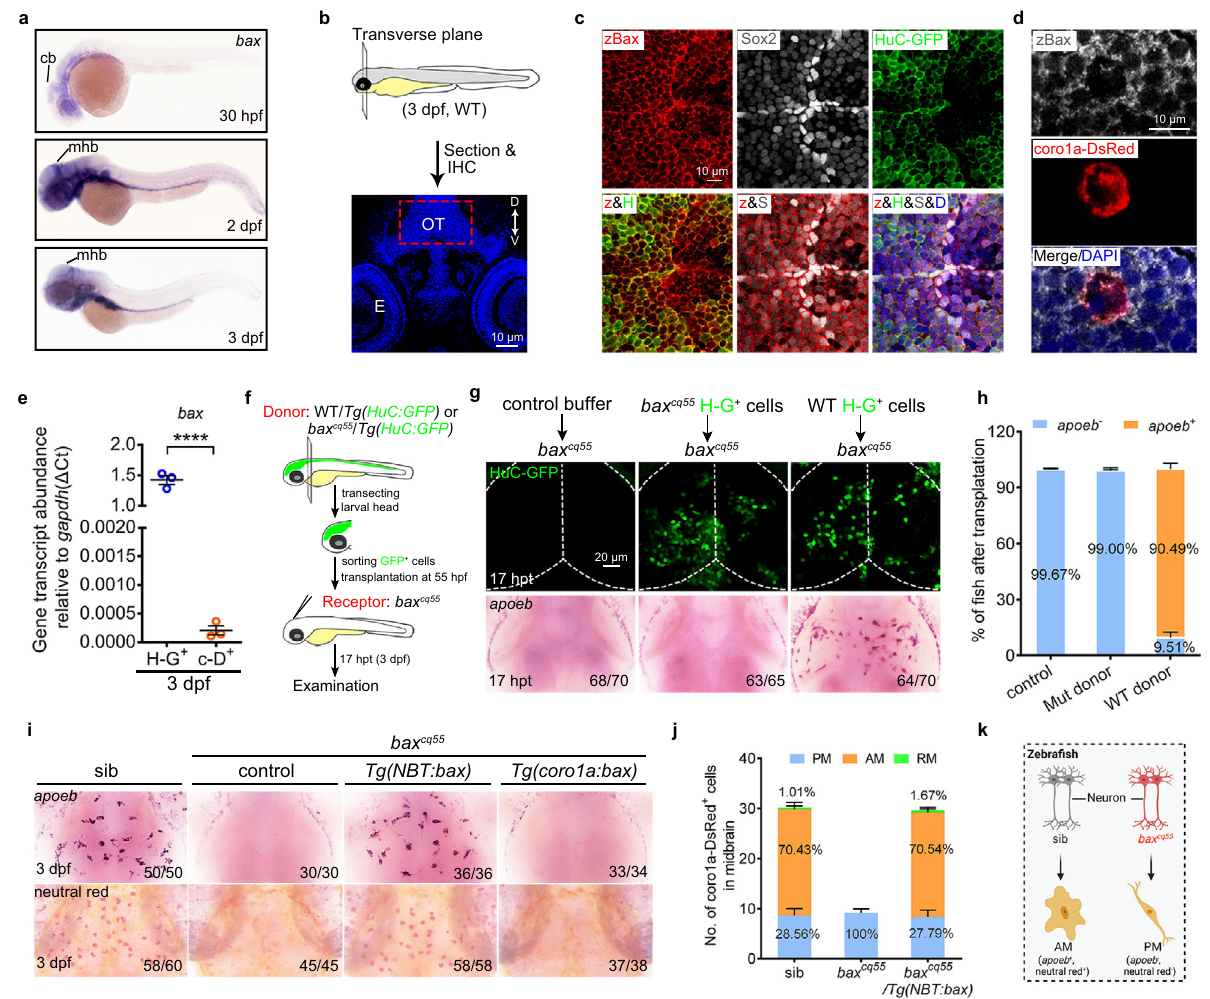
Fig. 2 | Bax is expressed in neurons and non-cell-autonomously regulates microglial maturation. a WISH of bax in 30 hpf, 2 dpf, and 3 dpf zebra fi sh embryos. b Schematic illustration of the anatomical position and observational region (red square) in ( c ) and ( d ), created with photoshop CS6. c , d Immuno fl uorescence of zBax (z) with Sox2 (S) and HuC-GFP (H) ( c ) or coro1a- Dsred ( d ) in 3 dpf OT region. e qPCR results of the bax transcriptional levelsin the sorted H-G + and c-D + cells from 3dpf WT midbrains. The data are from three independent experiments. Each dot represents an independent experiment. f The transplantation work fl ow created with photoshop CS6. g Fluorescent images of H-G + neurons(top)and WISHof apoeb (bottom)in bax cq55 recipientmidbrainsat17 hpt. h The percentage of bax cq55 recipients showing rescued apoeb + signals in ( g ). The number in each histogram indicates the average percentage. Data are